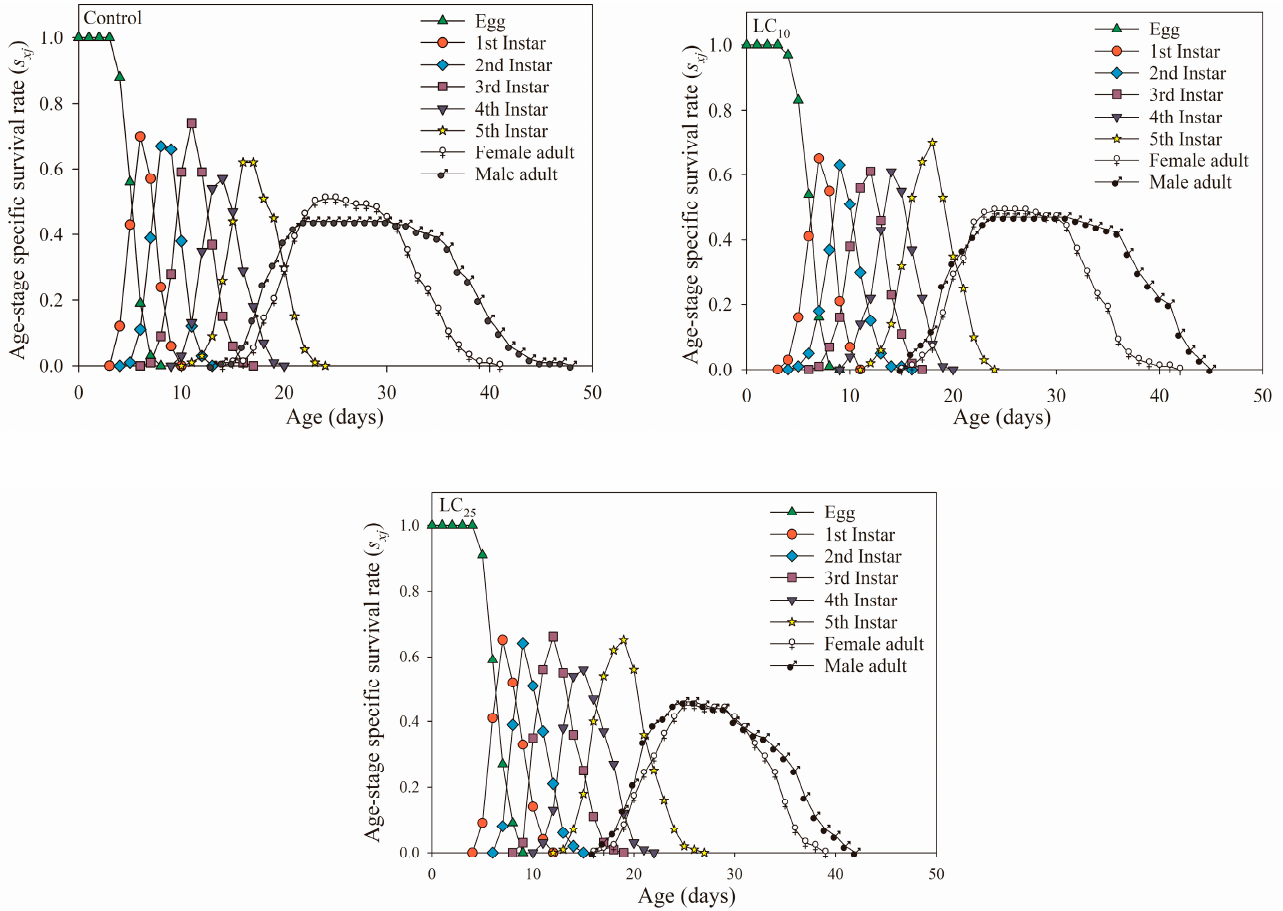
Figure 1. Age-stage-specific survival rates ( s xj ) in the control, Beauveria bassiana LC 10 - and LC 25 - treated F 1 generation of Sogatella furcifera .